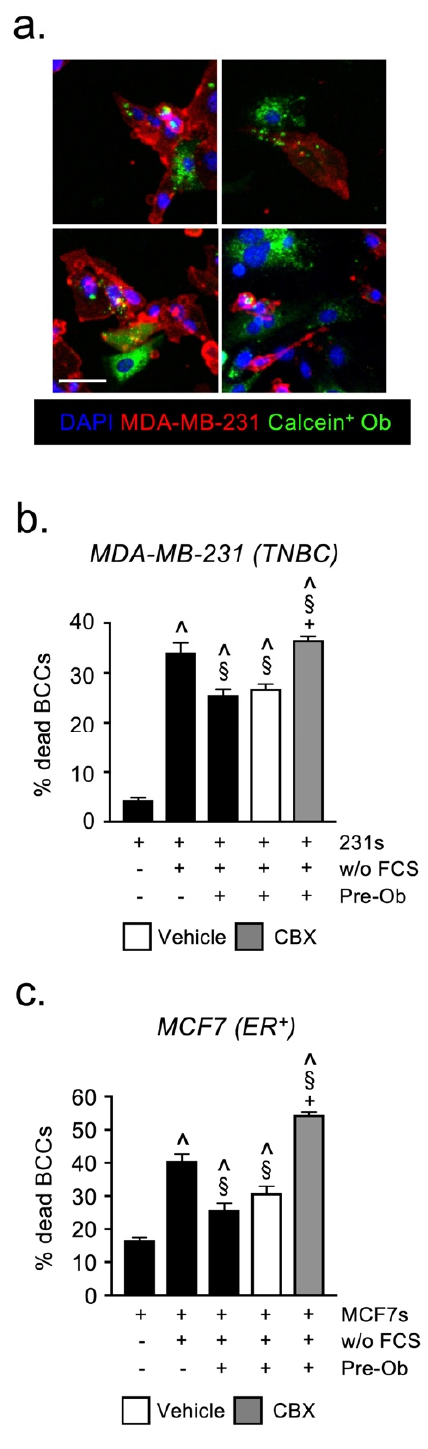
Figure 6. Gap junction signaling with osteoblasts protects BCCs from serum deprivation-induced cell death. ( a ) Representative images of gap junctional-mediated calcein transfer from labeled pre-Ob to MDA-MB-231 cells, in vitro. Flow cytometric quantification of ( b ) MDA-MB-231 and ( c ) MCF7 under serum-free conditions in the presence of pre-Ob and the gap junction inhibitor carbenoxolone or vehicle. (CBX = Carbenoxolone, w/o FCS = without FCS; scale bar = 50 µ m; ˆ sig. dif. w.r.t. BCCs under full serum ( p < 0.0001), § sig. dif. w.r.t. BCCs under serum-free conditions ( p < 0.001), + sig. dif. w.r.t. vehicle ( p < 0.001); n = 4).